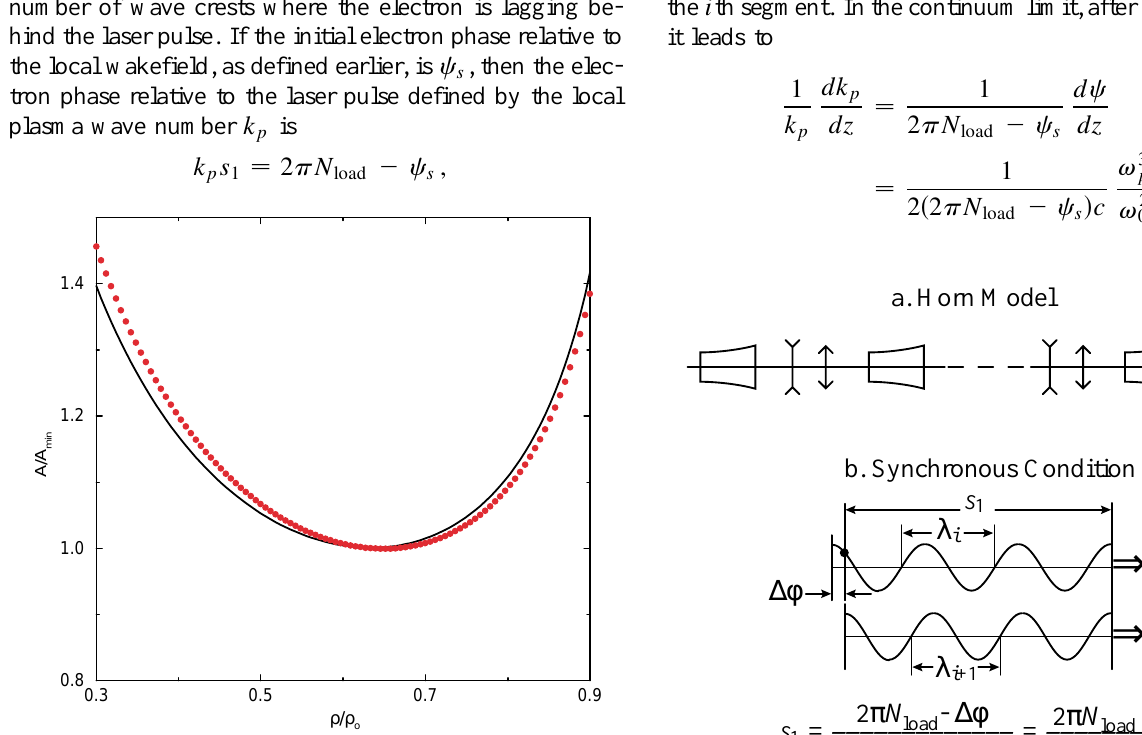
FIG. 8. (Color) Relationship between the normalized cross sec- tion and the normalized density function in a nozzle flow. The solid circles are for the monoatomic plasma and the curve is for the diatomic plasma.